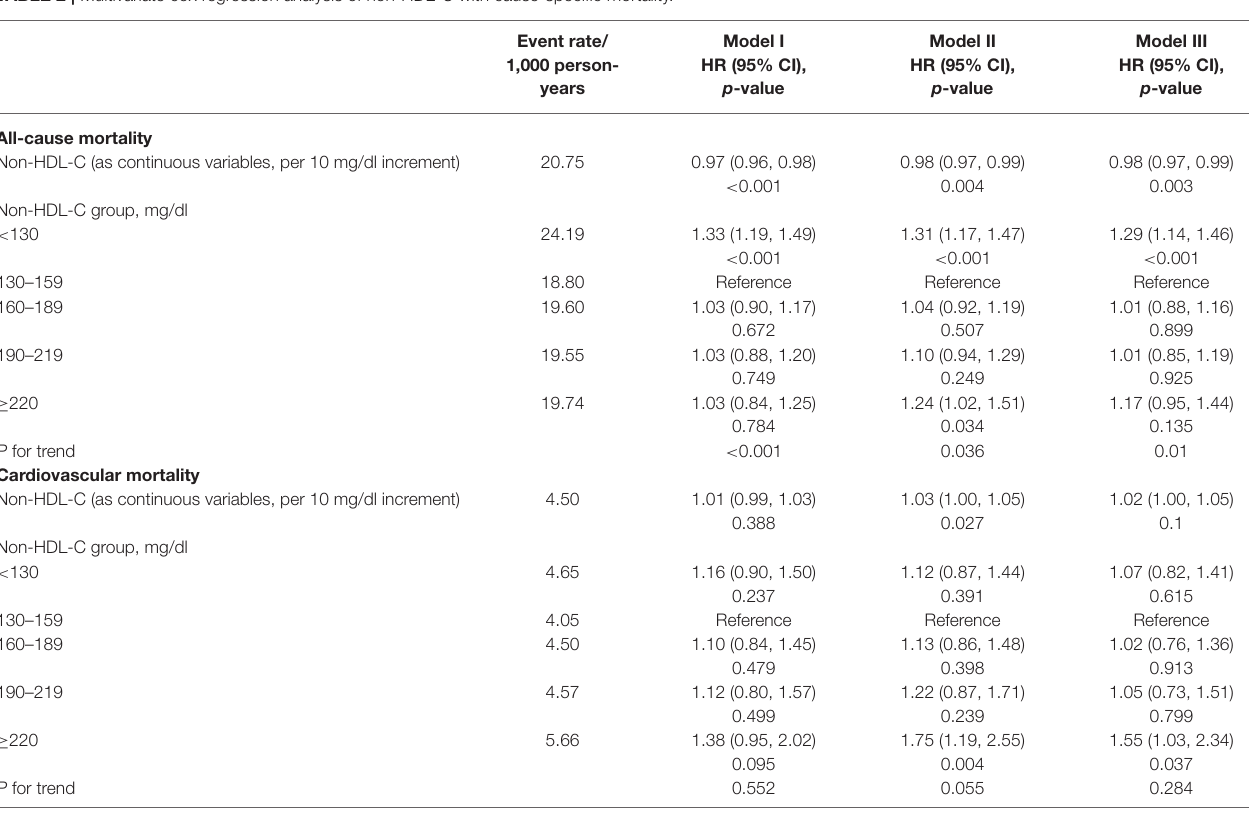
TABLE 2 | Multivariate cox regression analysis of non-HDL-C with cause-specific mortality.